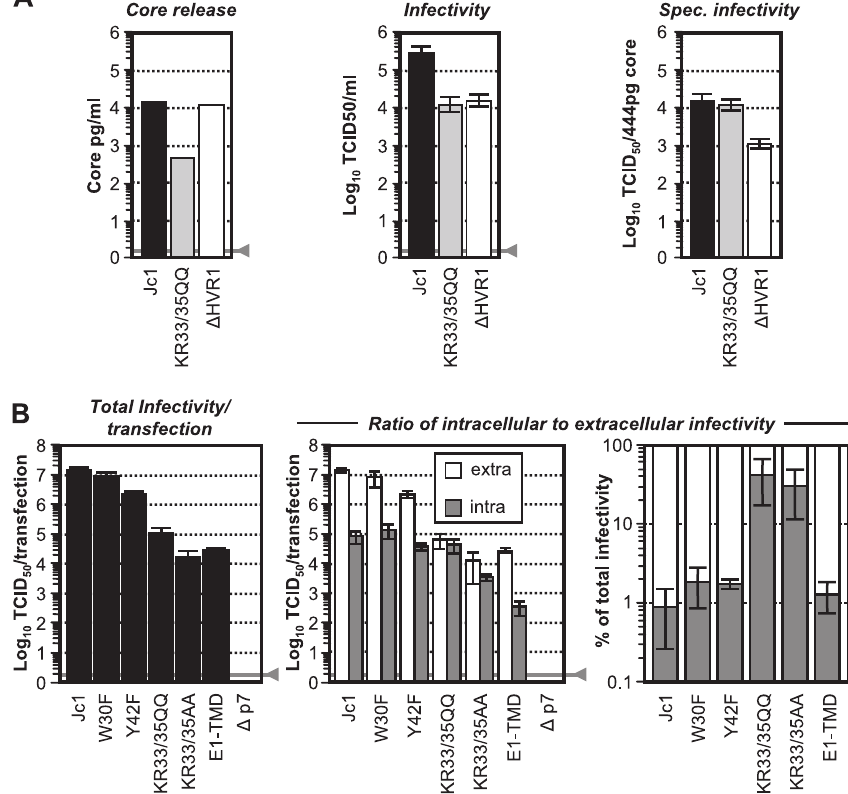
Figure 5. Specific Infectivity and Efficiency of Virus Assembly and Release of Jc1 with Mutated p7 (A) Huh7-Lunet cells were transfected with indicated genomes, and 48 h post-transfection culture fluid was harvested for quantification of core protein by ELISA (left panel) and infectivity by TCID 50 assay (middle). The specific infectivity of the given viruses was determined by dilution of Jc1 and D HVR1 to the same quantity of core protein as KR33/35QQ (444 pg) and titration by using the limiting dilution assay. (B) Cells were transfected as in (A) and 48 h post-transfection supernatants were collected. In parallel, virus-producing cells were washed and lysed by repetitive cycles of freeze and thaw. Extracellular (white bars) and intracellular infectivity (gray bars) were determined by limiting dilution assay and are depicted in the middle. The panel on the left shows the total infectivity per plate, whereas the percentage of cell-associated and released infectivity expressed relative to the total amount of infectivity is given in the right. The gray lines denote the detection limits of the ELISA and the limiting dilution assay, respectively. Mean values of five independent experiments and the standard deviation of the means are